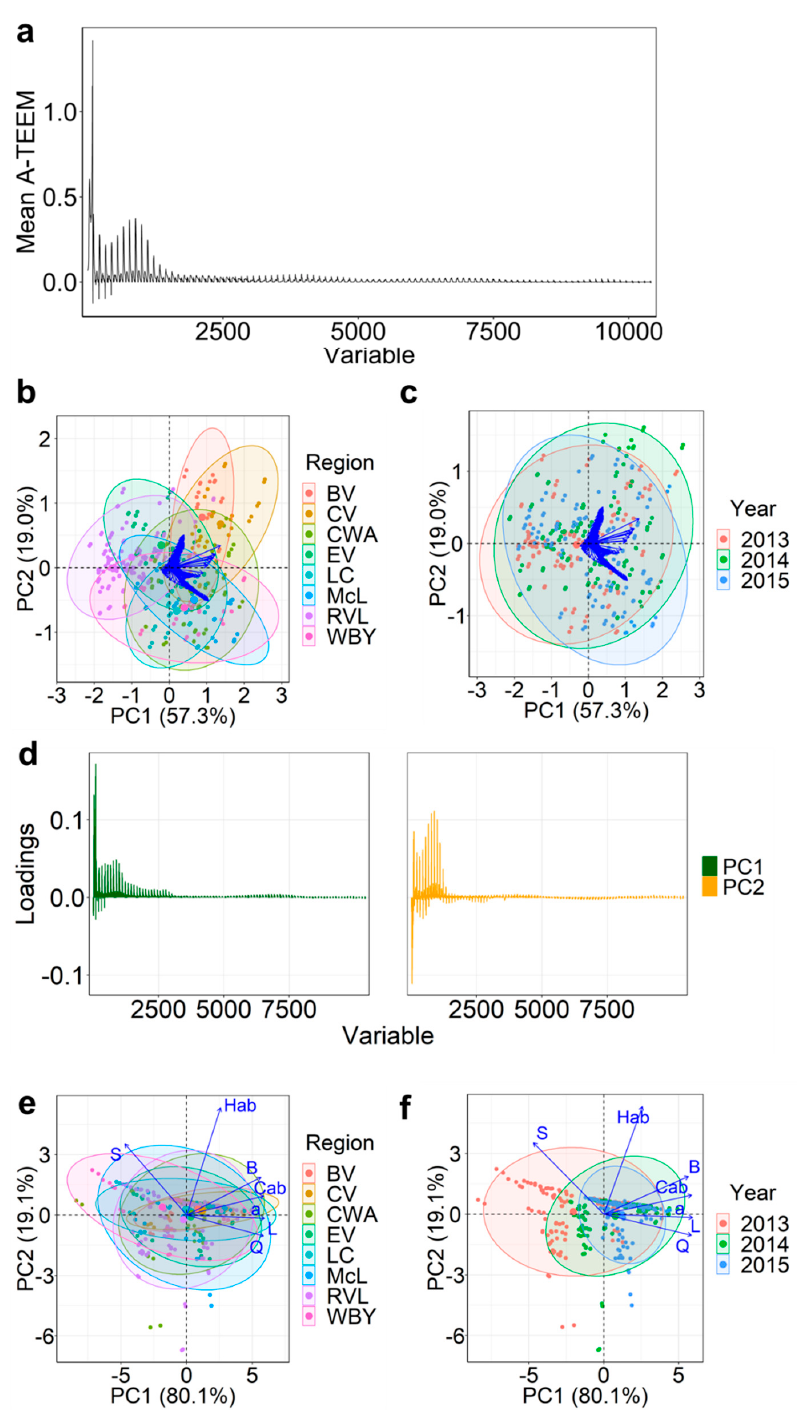
Figure 2. Absorbance-transmission and fluorescence excitation-emission matrix (A-TEEM) results showing ( a ) mean intensity of variable-level fused data, as well as PCA biplots showing scores and loadings on PC1 and PC2 with confidence ellipses for grape extract A-TEEM Train dataset (10,416 variables, blue arrows—labels not shown) according to ( b ) region and ( c ) year sampled, the A-TEEM variable loadings ( d ) on PC1 and PC2, and CIELAB Train dataset (7 variables, blue arrows) according to ( e ) region and ( f ) year sampled. Region abbreviations: BV, Barossa Valley; CV, Clare Valley; CWA, Coonawarra; EV, Eden Valley; LC, Langhorne Creek; McL, McLaren Vale; RVL, Riverland; WBY, Wrattonbully.